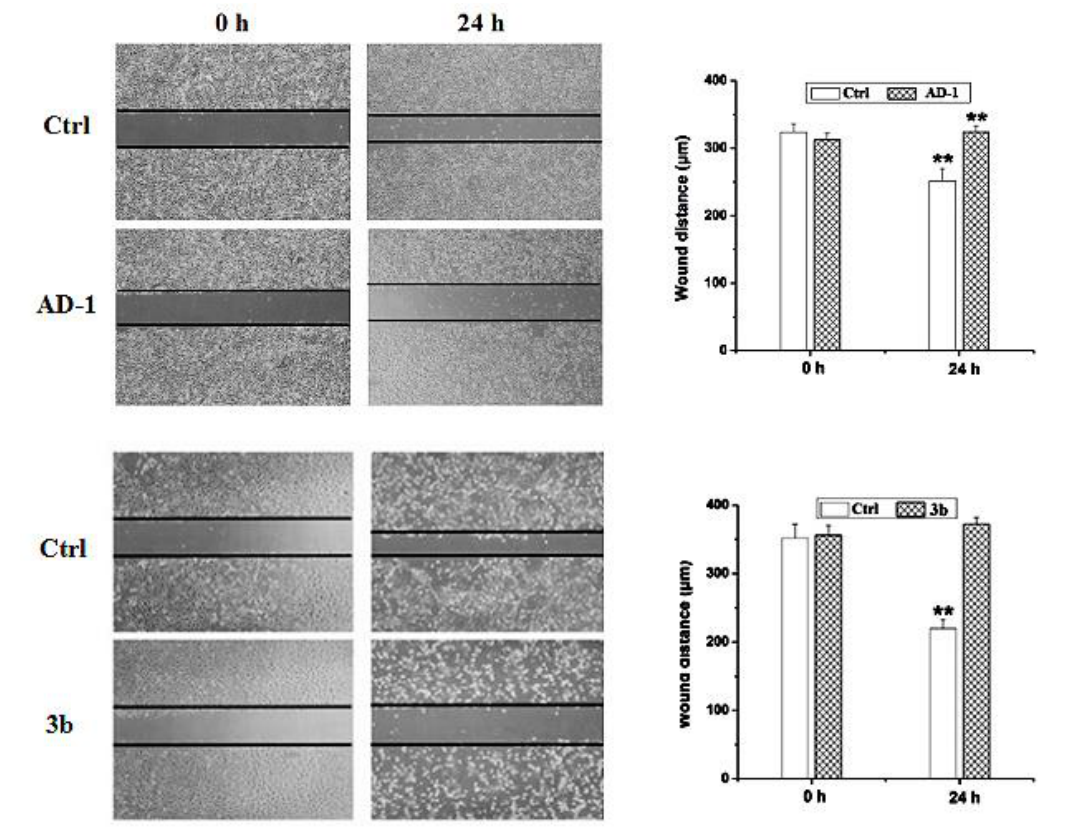
Figure 3. Wound distance of MCF-7 with 3b and AD-1.